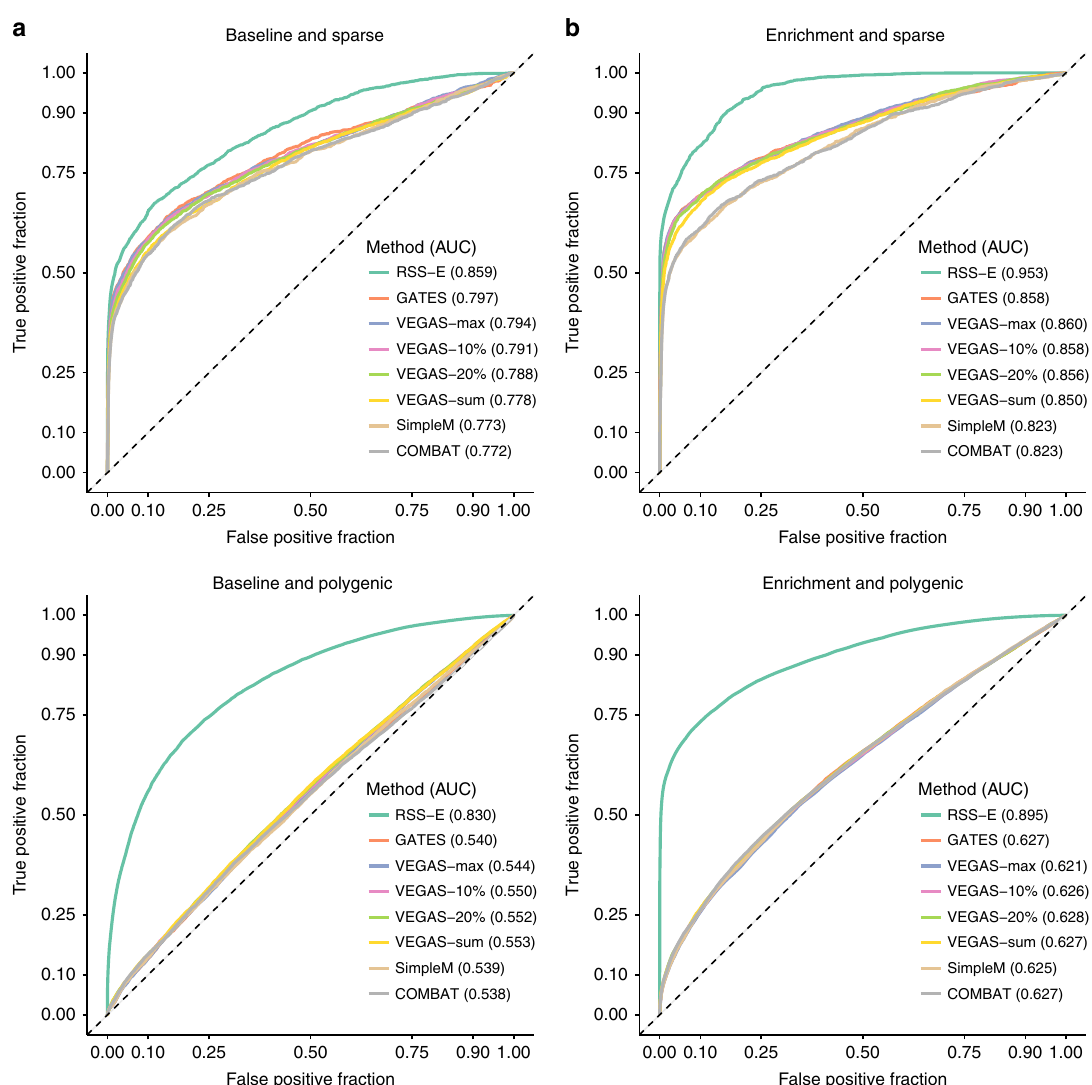
Fig. 3 Comparison of RSS-E to other methods for identifying gene-level associations from GWAS summary statistics. We used real genotypes 12 to simulate individual-level data with and without enrichment in the target gene set ( a “ baseline ” ; b “ enrichment ” ), each under two genetic architectures ( “ sparse ” and “ polygenic ” ), and then computed corresponding single-SNP summary statistics. On these summary data, we compared RSS-E with four other methods: SimpleM 17 , VEGAS 18 , GATES 19 , and COMBAT 20 . We applied VEGAS to the full set of SNPs (-sum), to a speci fi ed percentage of the most signi fi cant SNPs ( − 10% and − 20%), and to the single most signi fi cant SNP (-max), within 100 kb of the transcribed region of each gene. All methods are available in the package COMBAT (Methods). For each simulated dataset, we de fi ned a gene as “ trait-associated ” if at least one SNP within 100 kb of the transcribed region of this gene had nonzero effect. For each gene in each dataset, RSS-E produced the posterior probability that the gene was trait-associated. whereas the other methods produced association p values; these statistics were used to rank the signi fi cance of gene-level associations. Each panel displays the trade-off between false and true gene-level associations for all methods in 100 datasets of a given simulation scenario, and reports the corresponding AUCs. Simulation details and additional results are provided in Supplementary Figures 6,